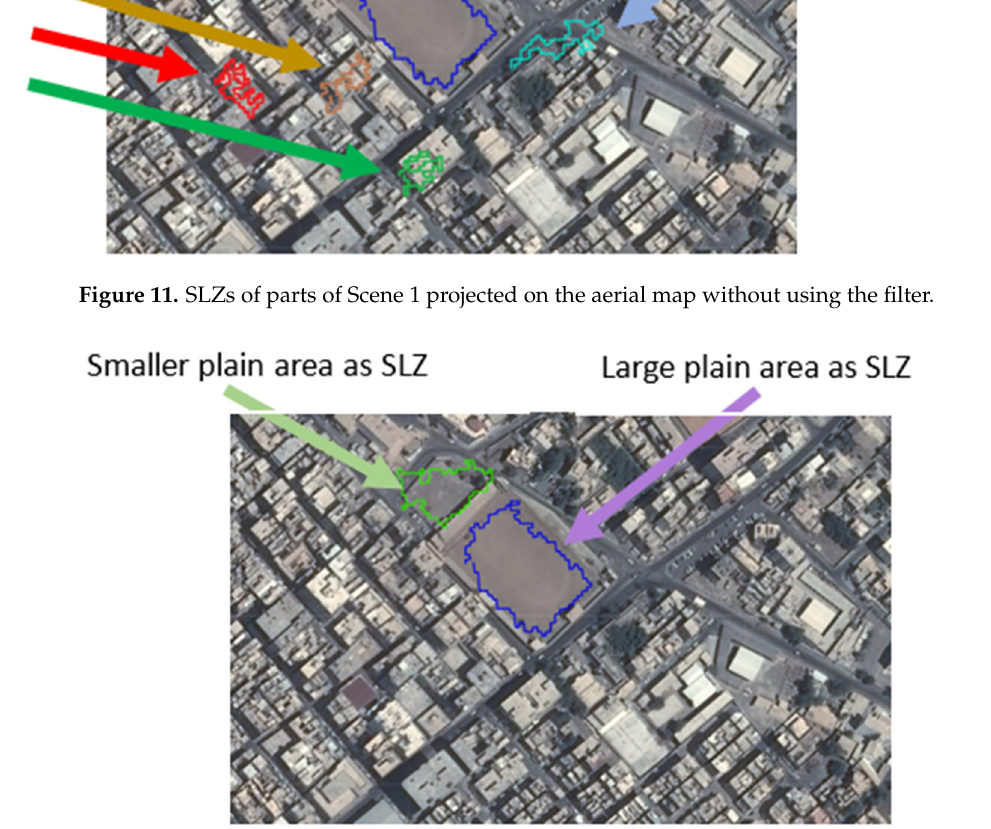
Figure 12. The aerial map has been fi ltered to identify safe landing zones (SLZs) for a helicopter in Scene 1, and these SLZs are now projected on the map.